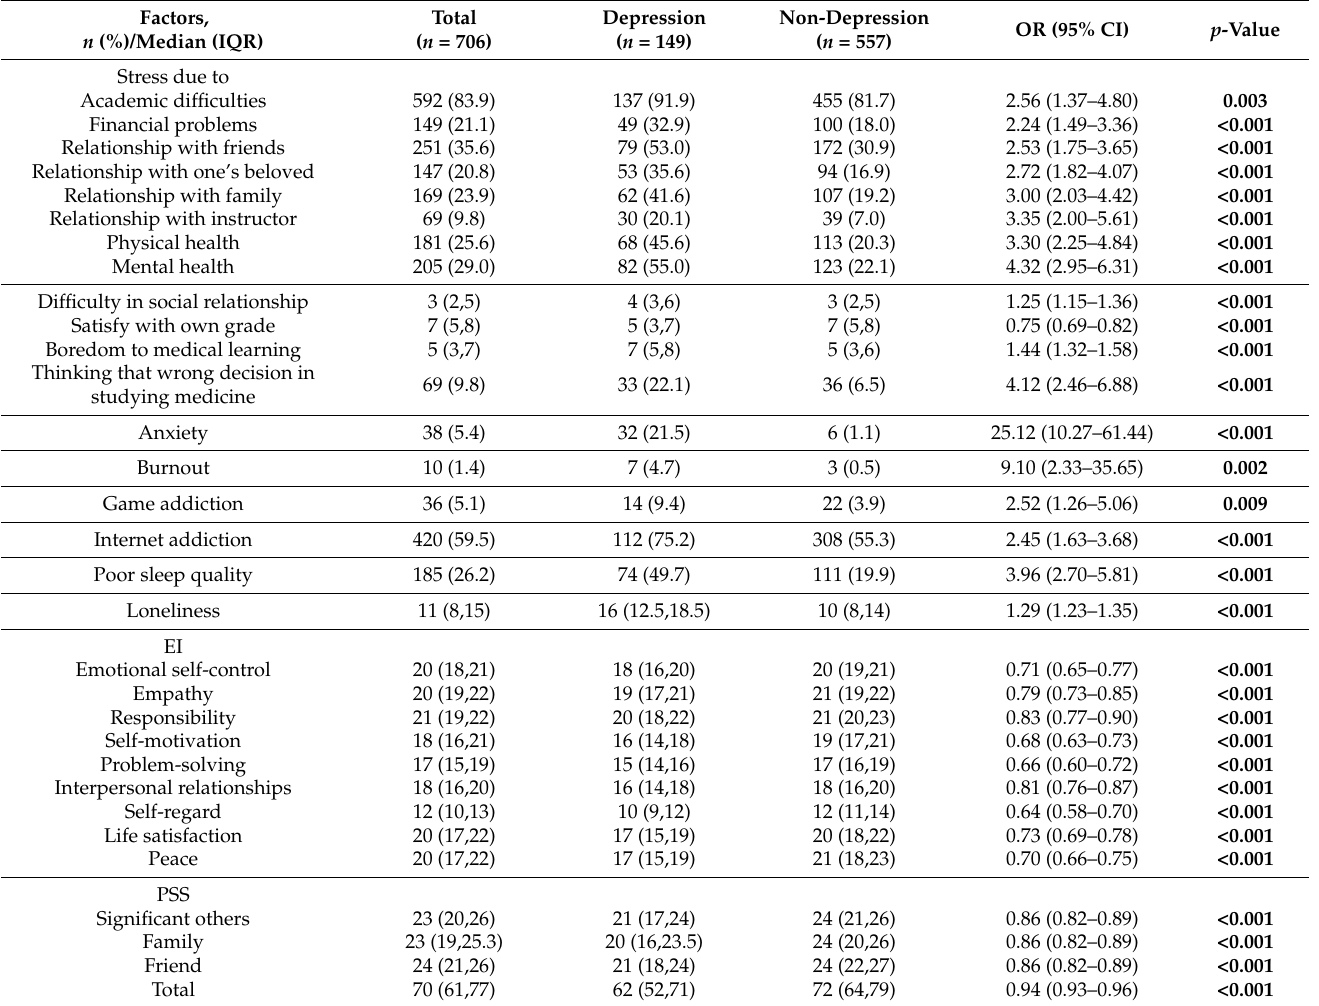
Table 3. Psychiatric problems and possible protective factors correlated with